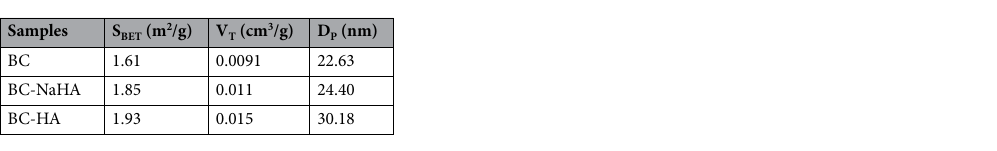
Table 4. Poreous structure parameters of BC, BC-NaHA and